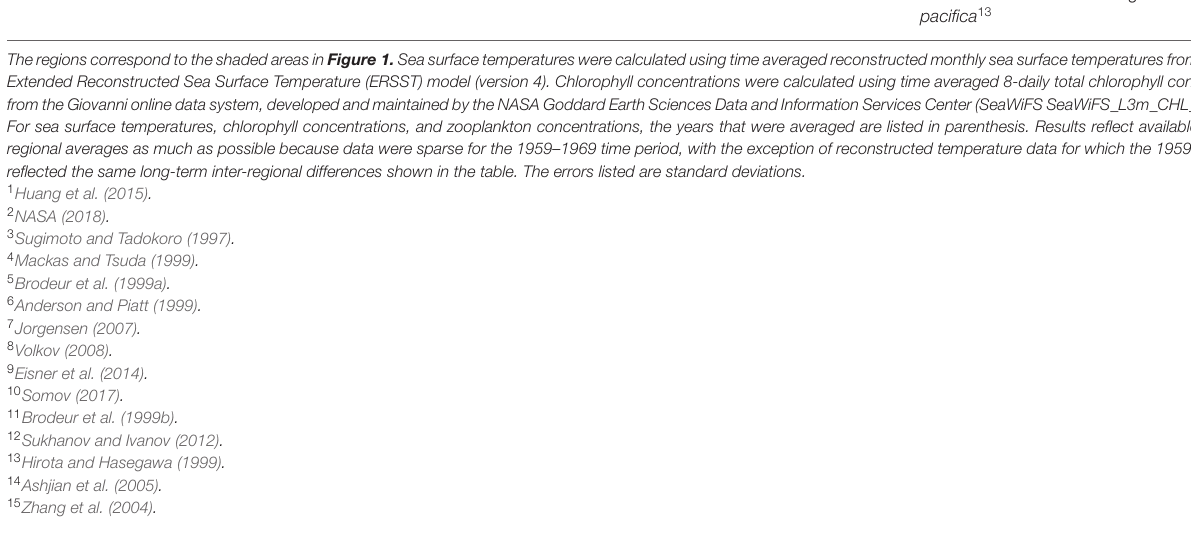
Large Sea surface Chlorophyll dominated continental temperature ecosystem shelf